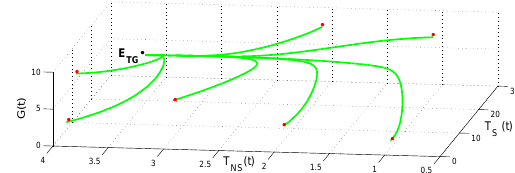
Fig. 1. 3D plot of the trajectories of system (1) showing that the savanna equilibrium point E TG point is stable. The red bullets represent di ff erent initial conditions.